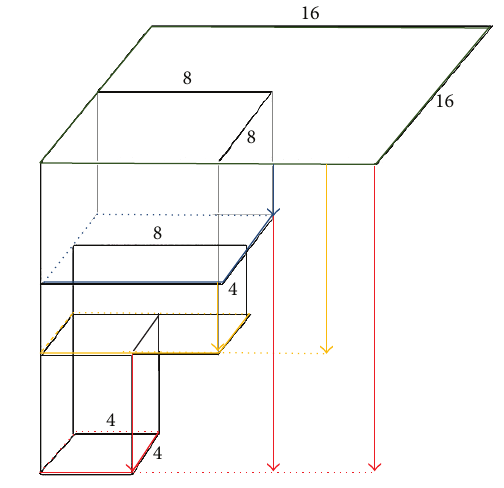
Figure 9: Up-layer